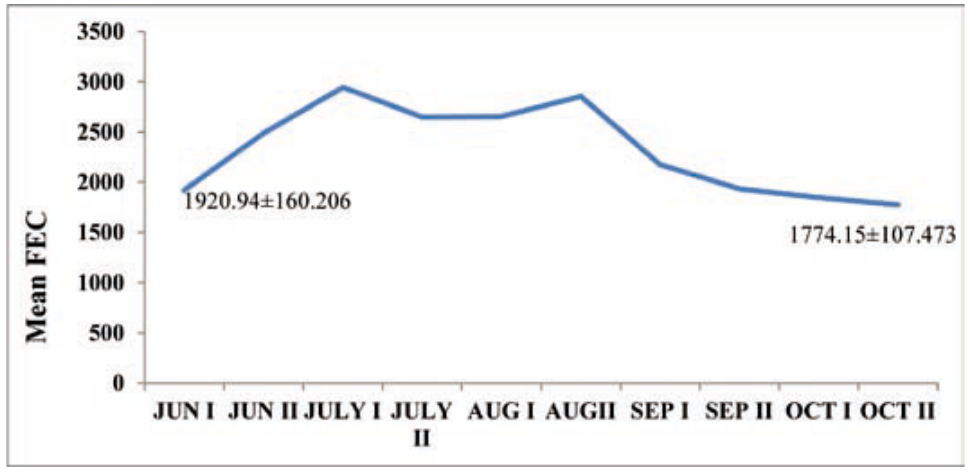
Fig.1. Incidence of strongylosis at fortnightly intervals from June to October, 2021 in the native goats of Kerala